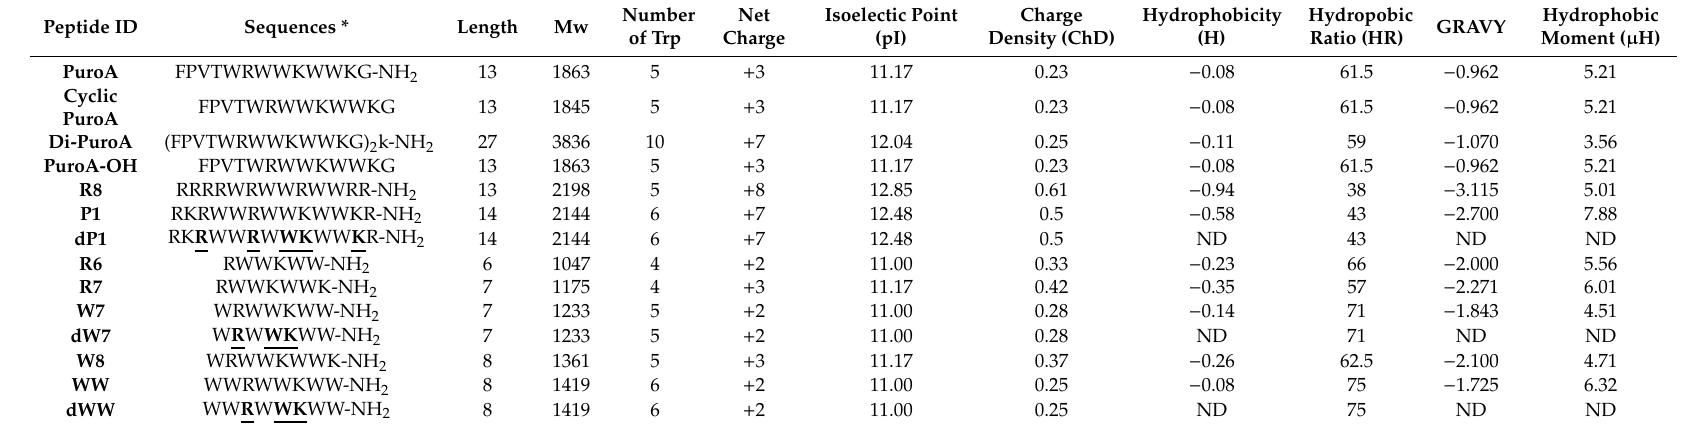
Table 1. Physico-chemical properties of the designed Trp-rich peptides (TRPs).